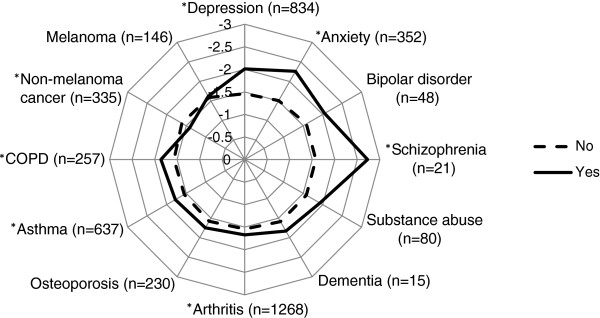
Diabetes-specific quality of life according to the presence or absence of comorbidities. Results are expressed as least-square means, Yes = Has ever been told by a doctor or nurse that they have the condition, COPD = Chronic Obstructive Pulmonary Disease, *p <0.05 after adjustment for sampling region, sex, age, duration of diabetes and treatment regimen, n = the number of participants with the condition.